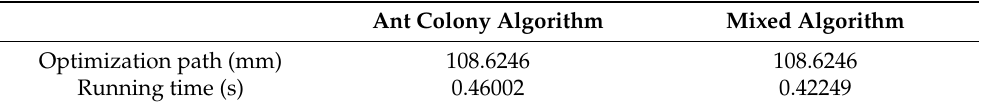
Figure 21. Distribution of solder joints belonging to each processing frame. ( a ) Processing frame 1, ( b ) Processing frame 2, ( c ) Processing frame 3, ( d ) Processing frame 4.